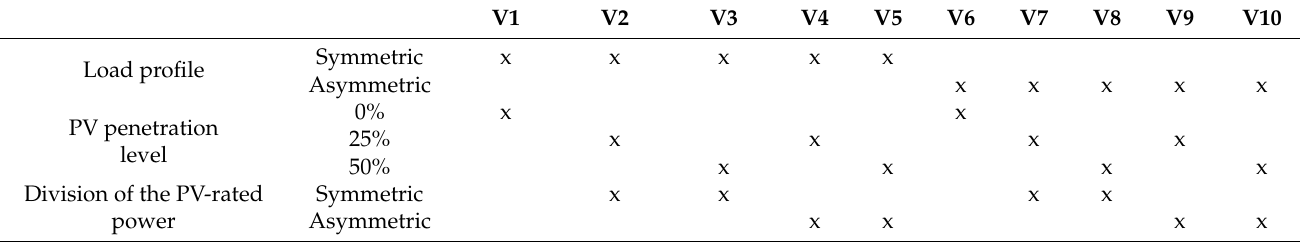
Table 2. The ten variants of operating conditions used in yearly simulations of the CIGRE test